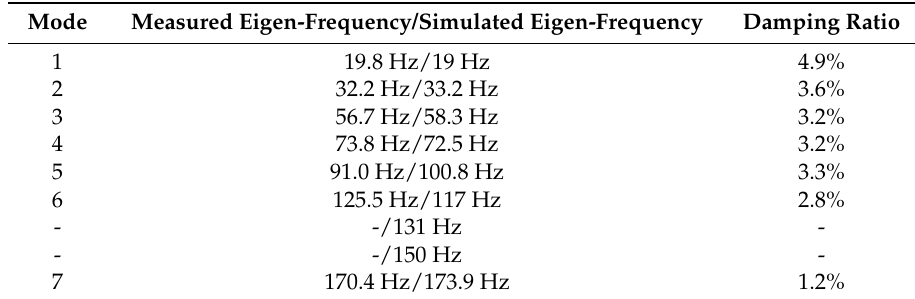
Table 1. Measured and simulated Eigen frequencies of the bending modes and the measured corresponding damping ratios.